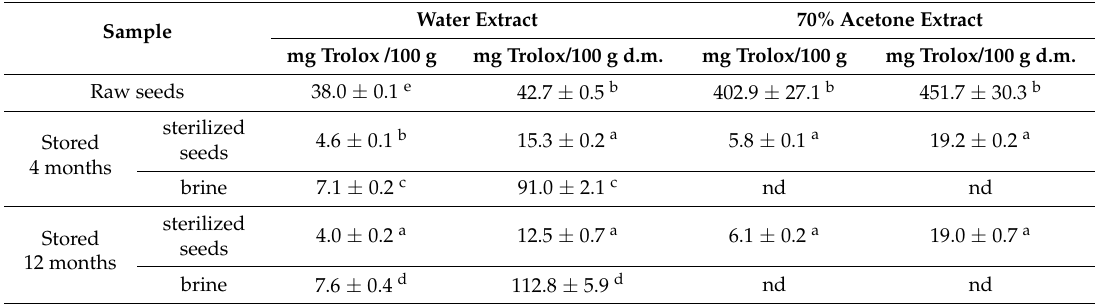
Table 5. Antiradical activities of bean seed extracts and brine against DPPH • (nd—not determined).